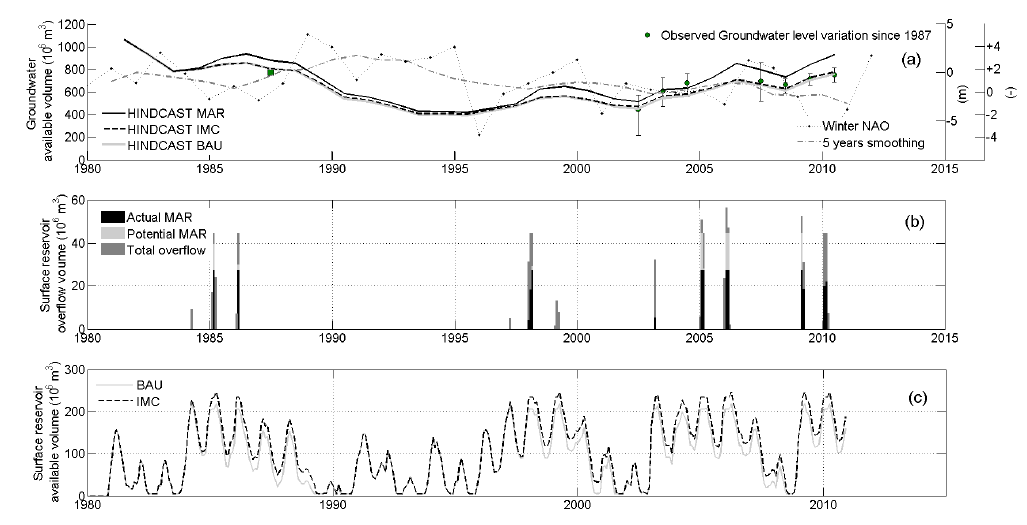
Figure 4. Panel ( a ): expected impact of adaptation scenarios on the groundwater available volume and observed groundwater level variation with associated spatial variability (error bar) (right axes). The Winter North Atlantic Oscillation and associated 5 years smoothing are reported on a second right axis. Panel ( b ): total overflow from the surface reservoir, potential overflow available for the aquifer recharge and actual volume infiltrated for the MAR Hindcast simulation. Panel ( c ): surface reservoir available volume for the BAU and IMC scenarios.